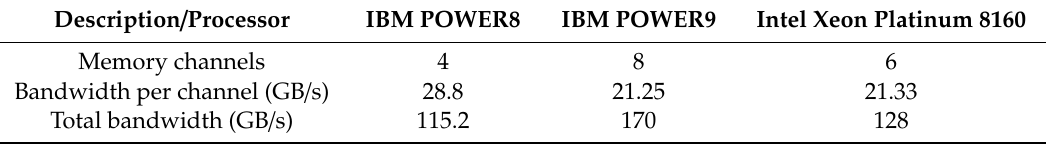
Table 5. Memory bandwidth (per